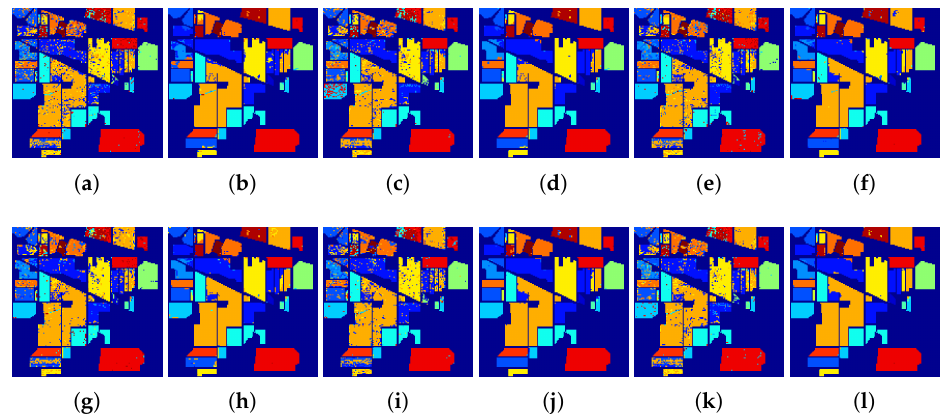
Figure 15. Classification maps of the ( a ) ELM, ( b ) ELM + GFFPC, ( c ) KELM, ( d ) KELM + GFFPC, ( e ) KSVM, ( f ) KSVM + GFFPC, ( g ) CNN, ( h ) CNN + GFFPC, ( i ) MELM, ( j ) MELM + GFFPC, and the proposed ( k ) DKELM, and ( l ) DKELM + GFFPC for the Indian Pines.